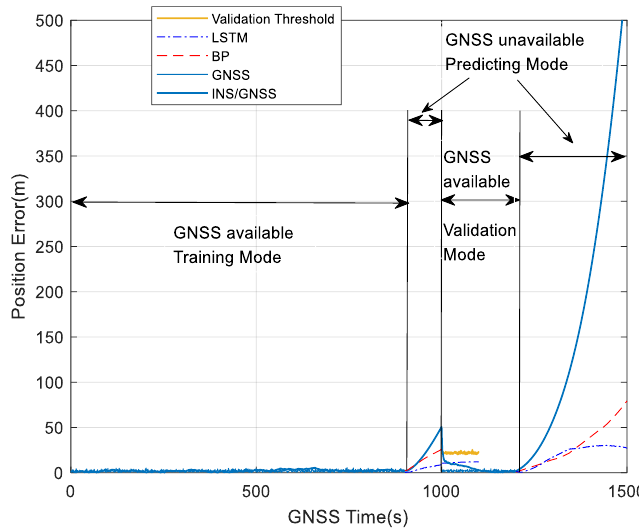
Figure 14. Position errors with different algorithms.